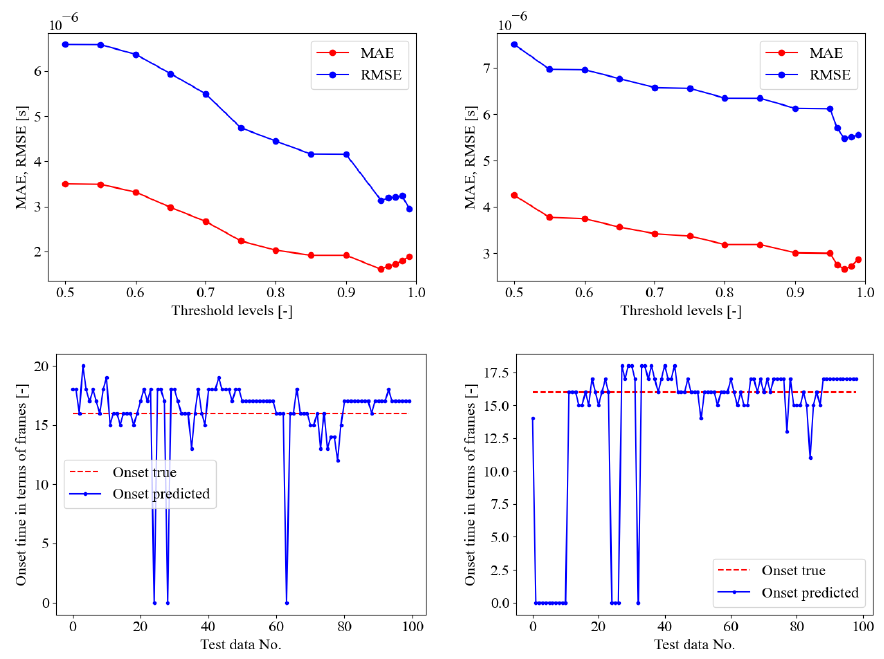
Figure 11. Fine-tuned SED on PLB test A. Upper pane, crack class probability threshold evaluation, lower pane onset time predictions in terms of frames on the PLB test sets B and C for optimal threshold. From left to right, PLB test B (optimal threshold of 99%), and C (optimal threshold of 98%). The onset time true values are always at a constant pre-trigger time of 256 µ s (frame No.